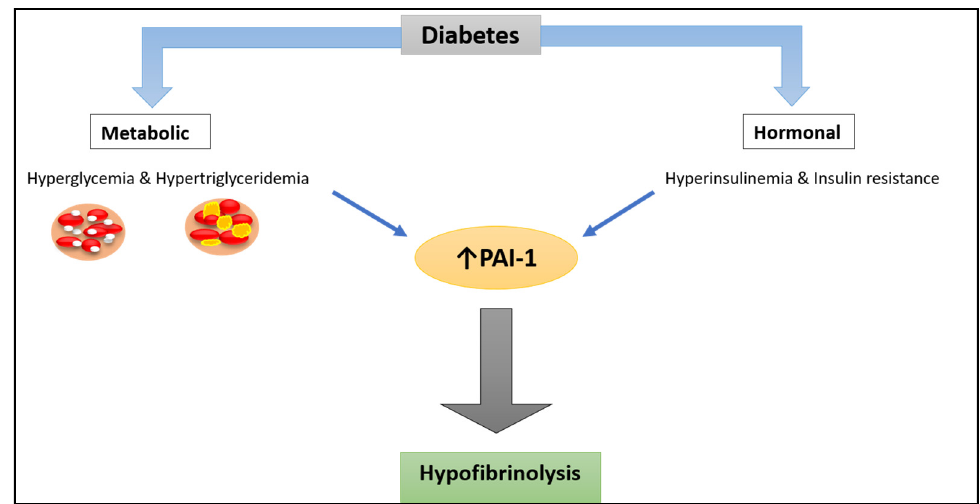
Figure 3. Mechanism of increased PAI-1 levels in diabetes. Hormonal (hyperinsulinemia) and metabolic (hyperglycemia and hypertriglyceridemia) derangements in T2D patients, seem to have a role in elevating PAI-1 levels in this population, resulting in hypofibrinolysis that causes pathological deposition of fibrin and damage to the tissues.